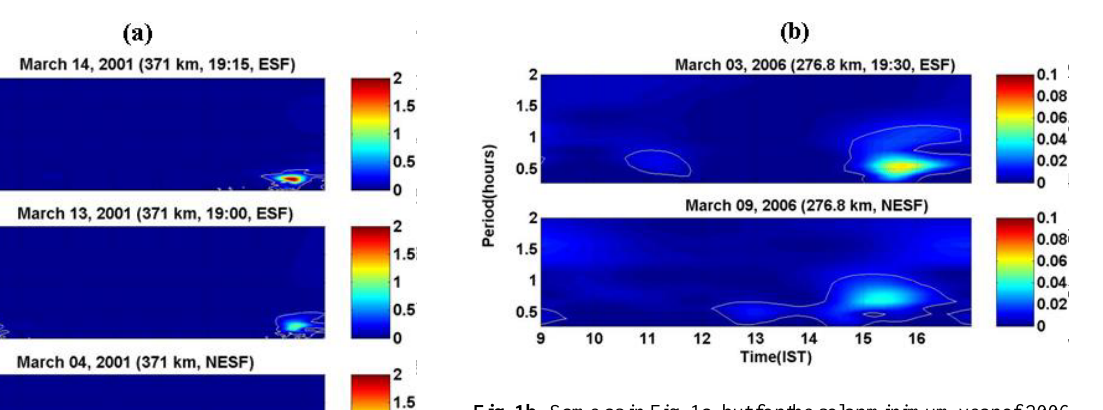
Fig. 1b. Same as in Fig. 1a, but for the solar minimum year of